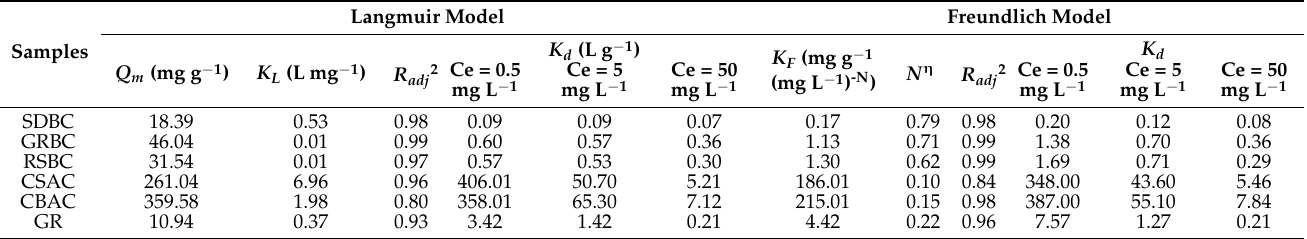
Table 3. Parameters of DEP sorption isotherm on different biochars fitted by Langmuir and Fre- undlich